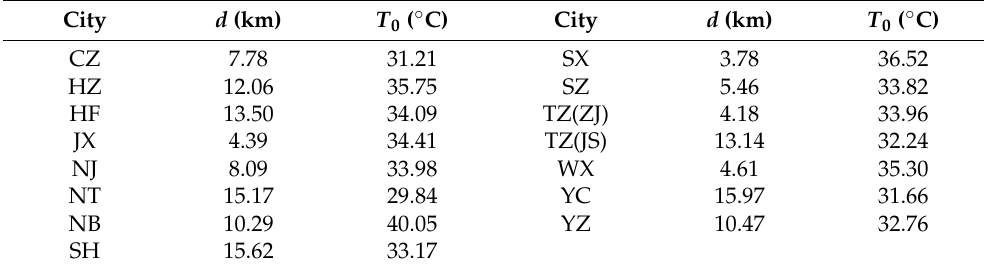
Table 1. Extension distance of surface urban heat island effect and background land surface tem- perature of the 15 cities.